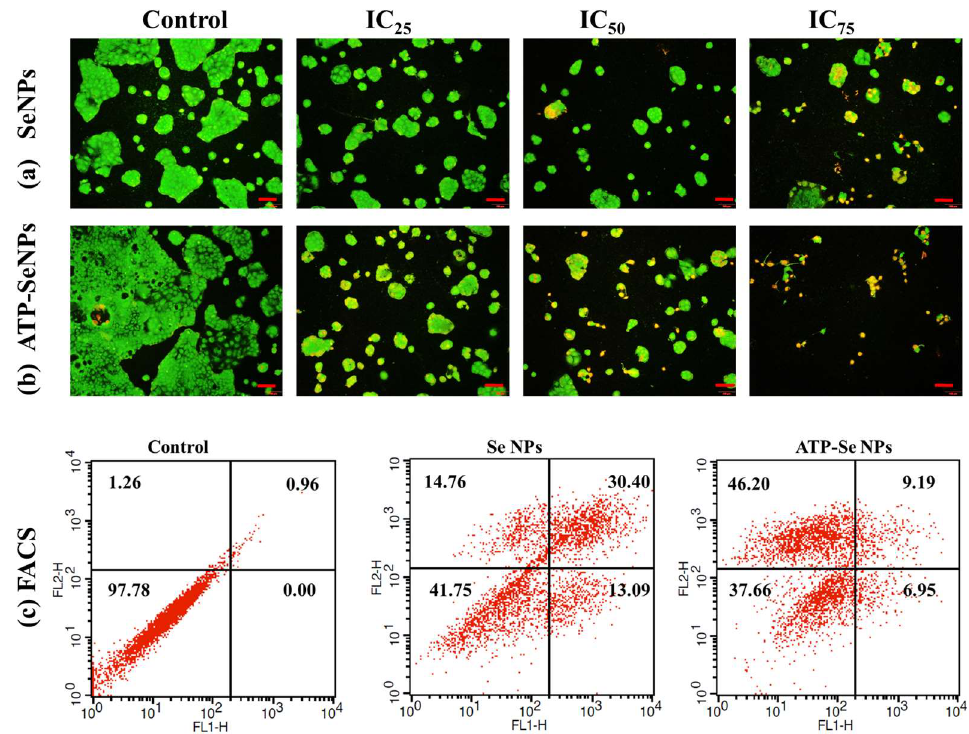
Figure 8. Analysis of SeNPs ( a ) and ATP-SeNPs ( b ) induced cell death stages in human colon